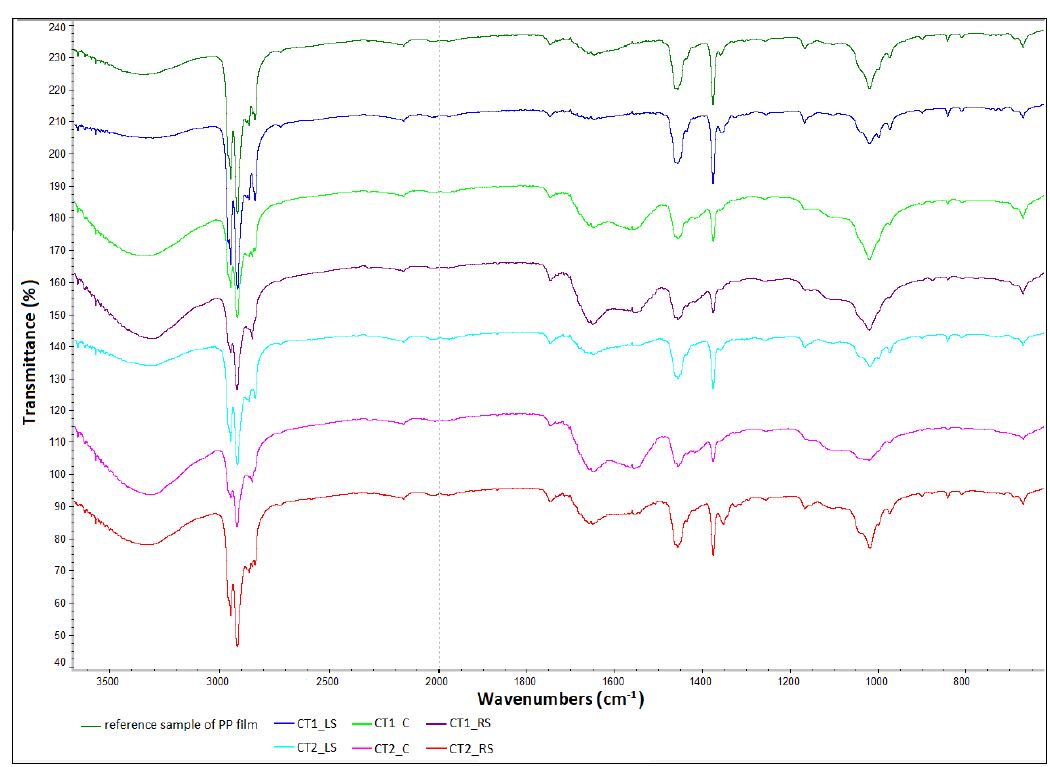
Figure 13. Summary of polypropylene spectra in relation to the reference spectrum.